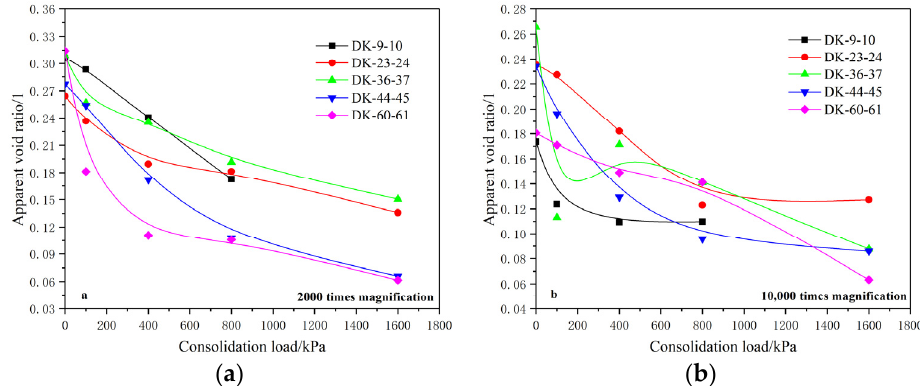
Figure 10. Relationship between the apparent void ratio and the consolidation load. ( a ) 2000 times magnification; ( b ) 10,000 times magnification.